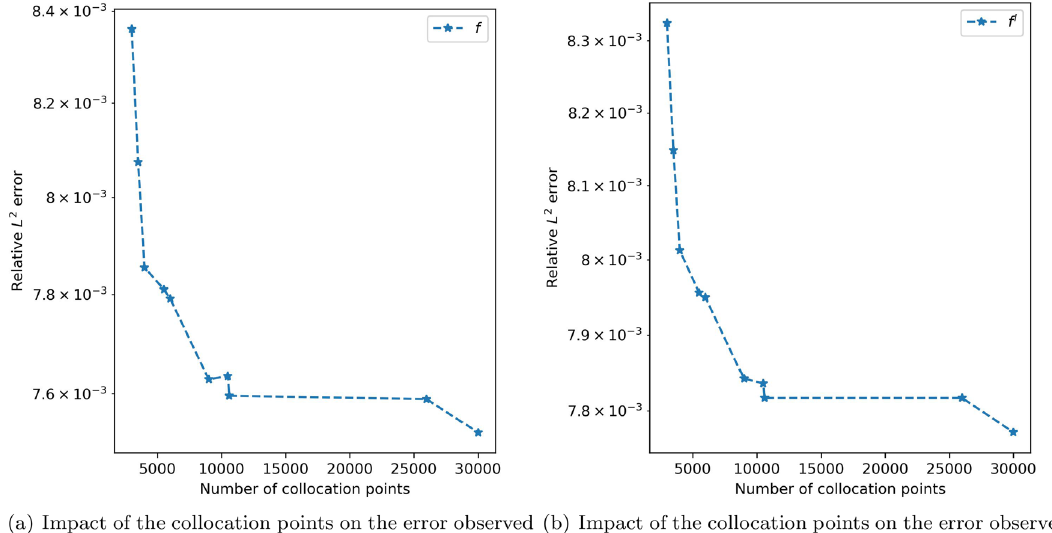
Figure 5. Collocation points versus